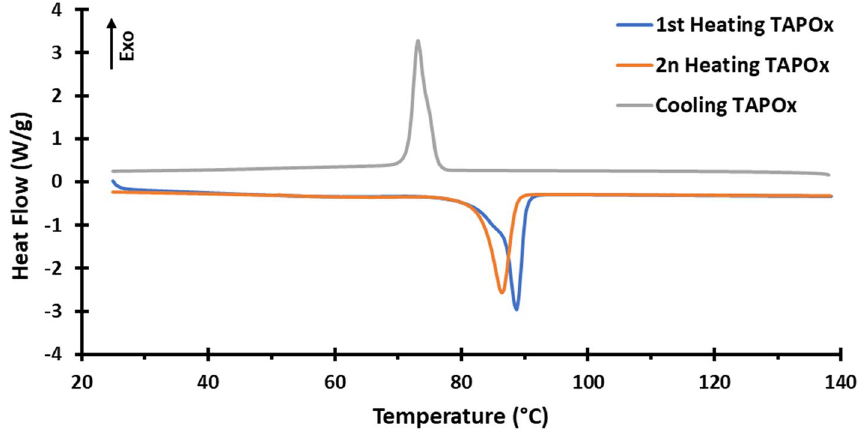
Figure 12. Calorimetric analysis of TAPOx; (blue) first heating, (orange) second heating, and (grey) cooling. Scan rate: 10 °C/min.